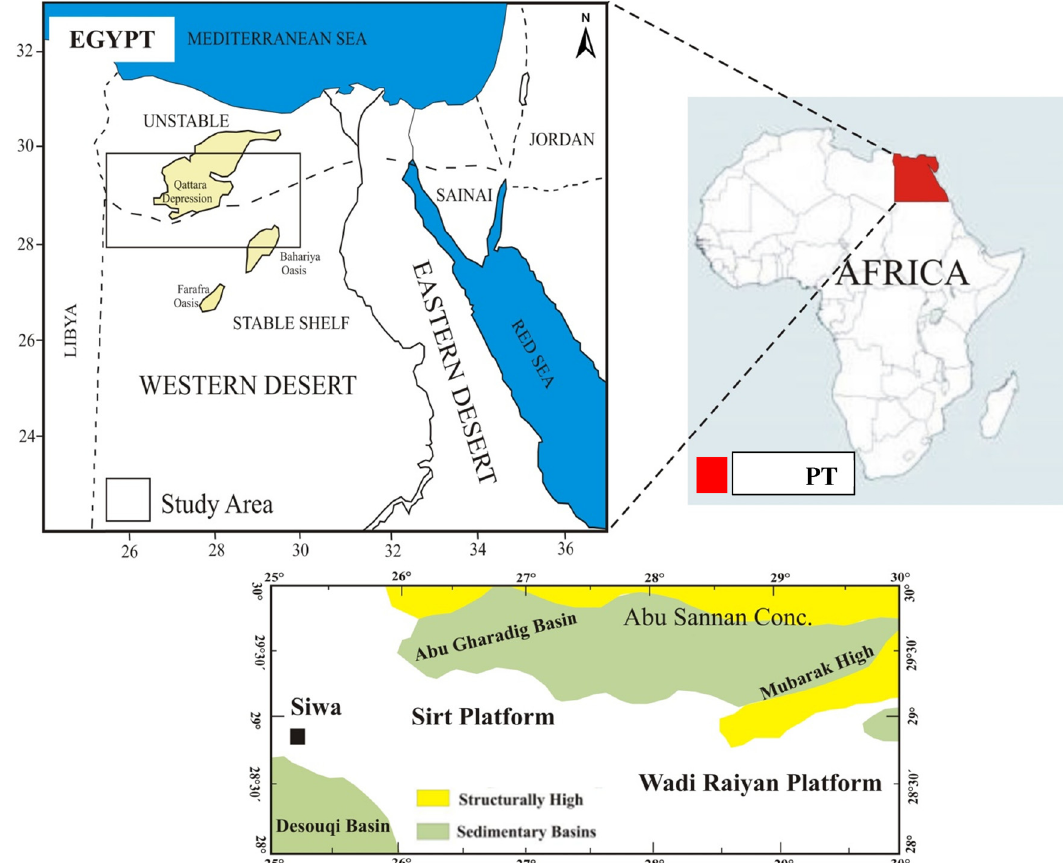
Figure 1: Location map of the studied